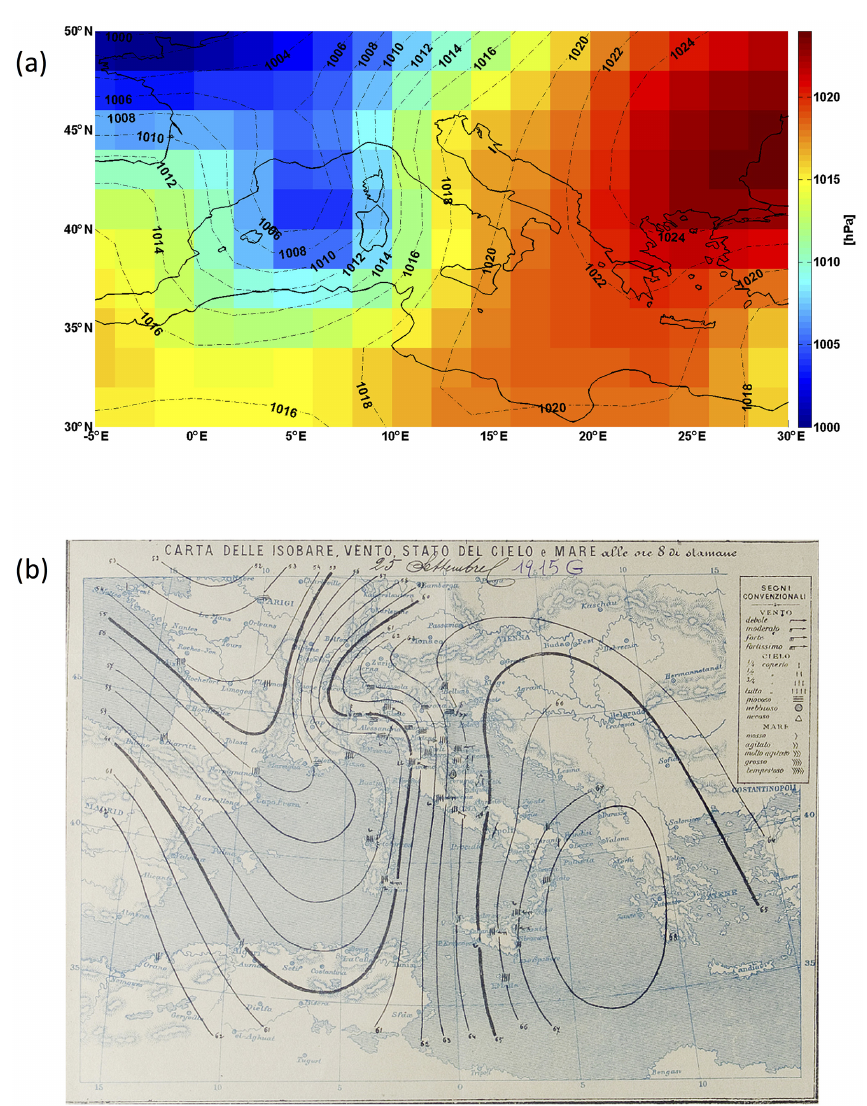
Figure 3. Panel (a) shows the same field as in Fig. 2c, but over the same area of the map in (b) . Panel (b) shows sea level pressure isobars on 25 September 1915 at 07:00UTC, as provided by the Italian Royal Meteorological